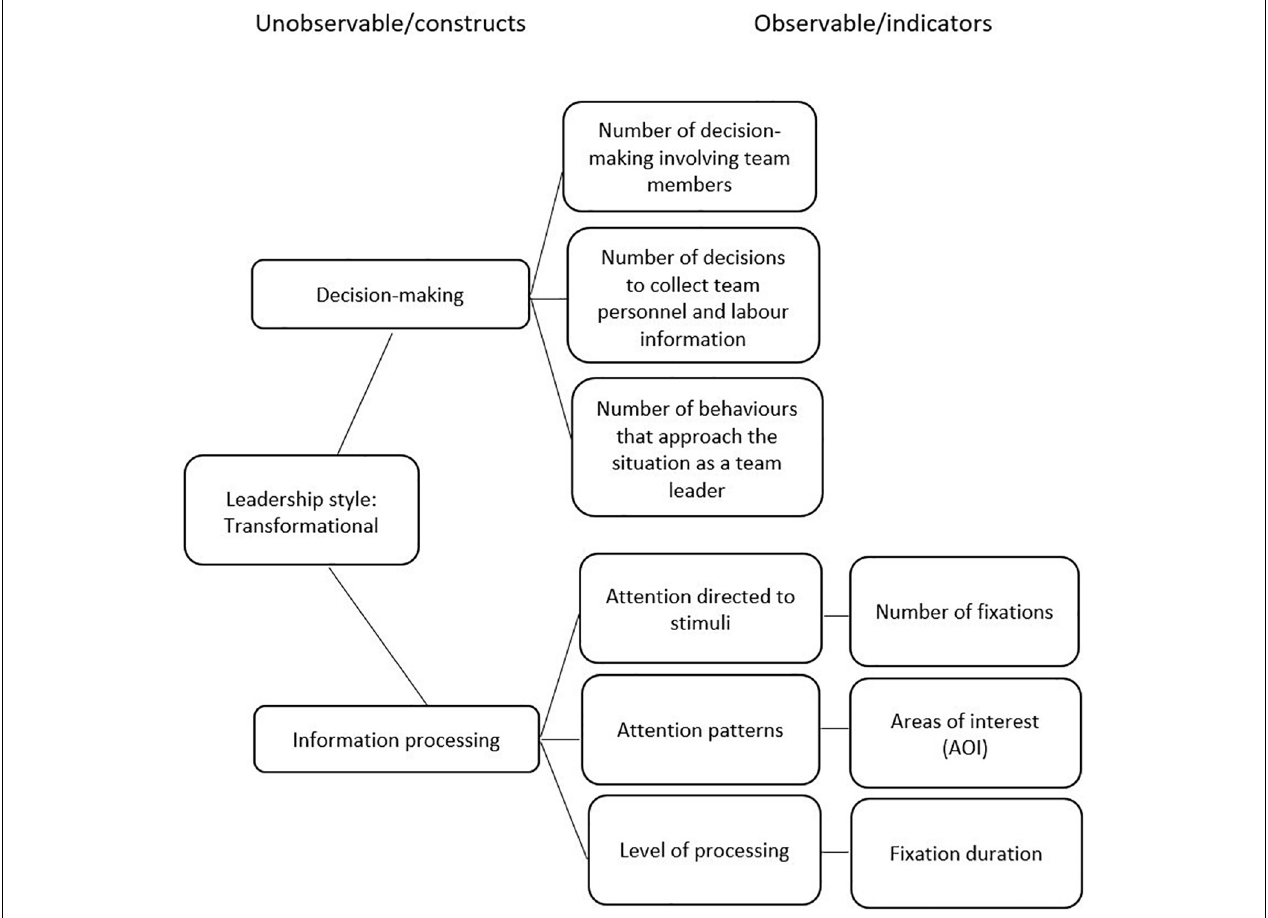
FIGURE 2 | Transformational